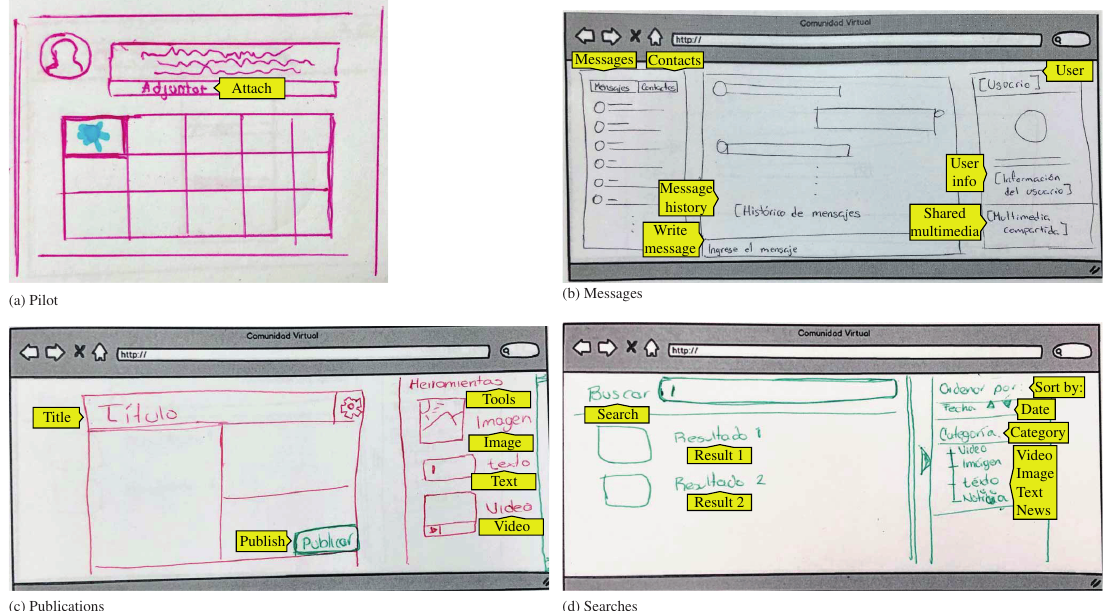
Figure 3. Samples of prototypes from the pilot tests ( a ) and from the actual tests ( b – d ).